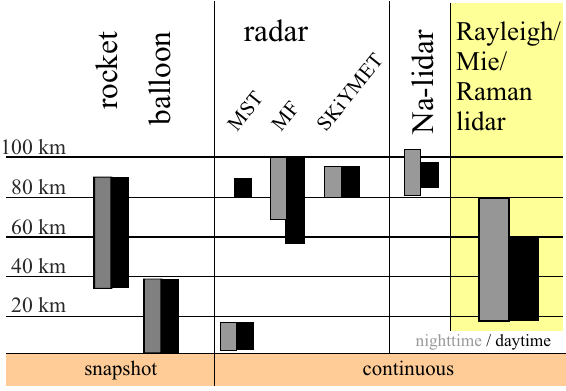
Fig. 1. Altitude range of different methods for sounding wind at the ALOMAR research station in Northern Norway.